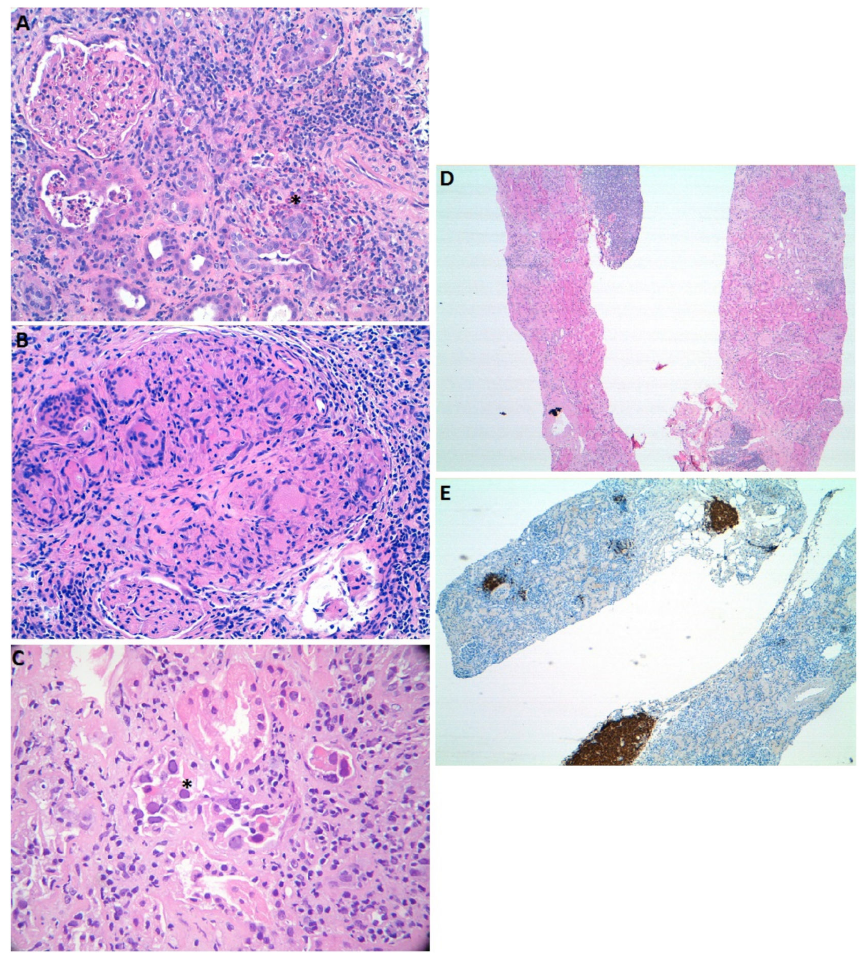
Figure 1. Light microscopy images illustrating acute interstitial nephritis cases with characteristic features. Panel ( A ). Extensive interstitial inflammatory infiltrates in a case of drug-induced acute tubulointerstitial nephritis. Eosinophils associated with peritubular infiltrates (*) (hematoxylin and eosin, 200 × ). Panel ( B ). Acute tubulointerstitial nephritis associated with Bacillus Calmette– Guerin treatment. Interstitial necrotizing granuloma (hematoxylin and eosin, 100x). Panel ( C ). Acute tubulointerstitial nephritis associated with BK virus infection. Intranuclear inclusions (*) and vacuolated cytoplasm (hematoxylin and eosin, 400 × ). Panel ( D , E ). Lymphocytic infiltration of the kidney in a patient diagnosed with marginal zone lymphoma. Infiltrating cells are CD20 positive (hematoxylin and eosin, 10 ×